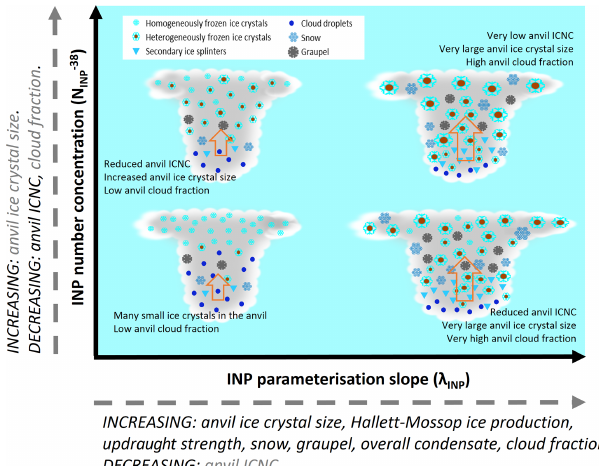
Figure 16. Schematic showing the key effects of the perturbations to absolute INP number concentration at − 38 ◦ C ( N INP − 38 ) and INP parameterisation slope ( λ INP ) on the deep convective cloud simulated in this study. Output variables written along the x and y axes in black indicate that they are primarily controlled by the uncertain input variable on that axis, while grey writing indicates a secondary or smaller effect of the uncertain input variable in ques-